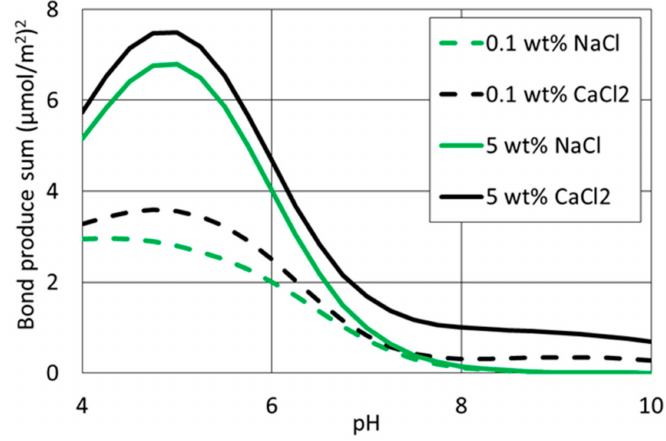
Figure 8. Bond product sum vs. pH with various ion type and